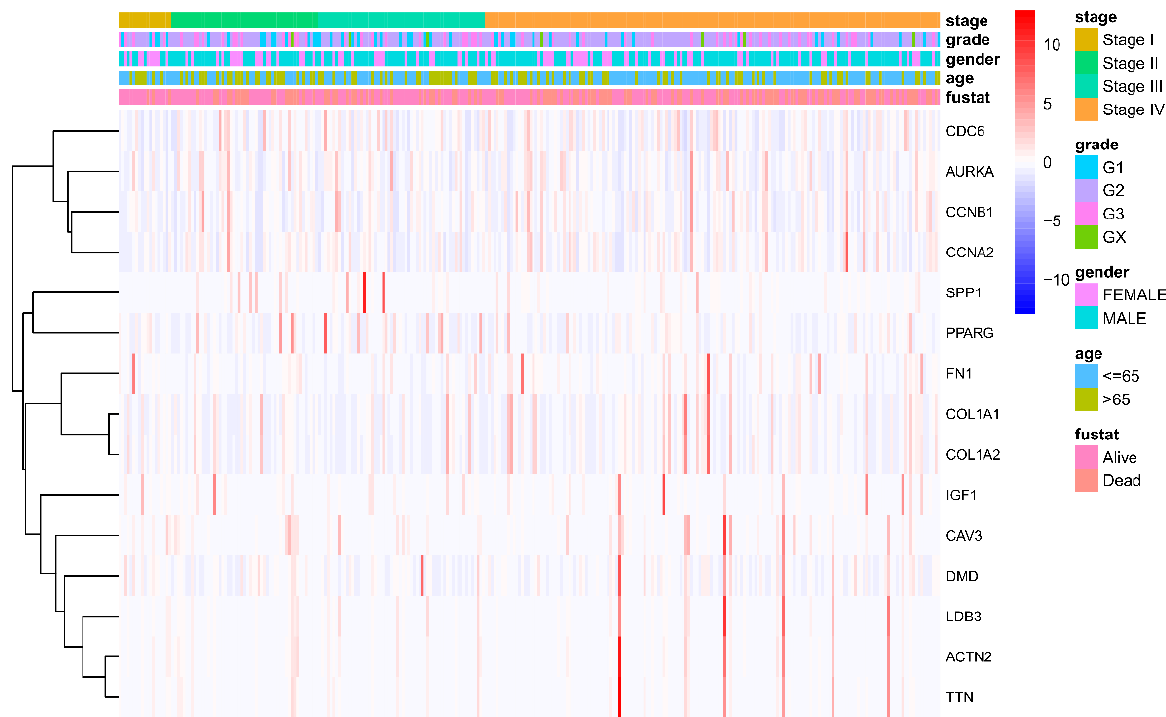
Fig. 5. Heat map shows the relative expression of 15 hub genes in TCGA OSCC patients and clinicopathological features. Grade: tu- mor differentiation, GX: grade cannot be assessed, G1: highly differentiated, G2: moderately differentiated, G3: poorly